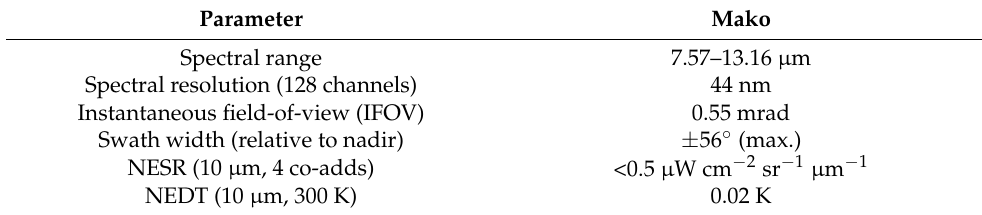
Table 1. Nominal sensor operating specifications.